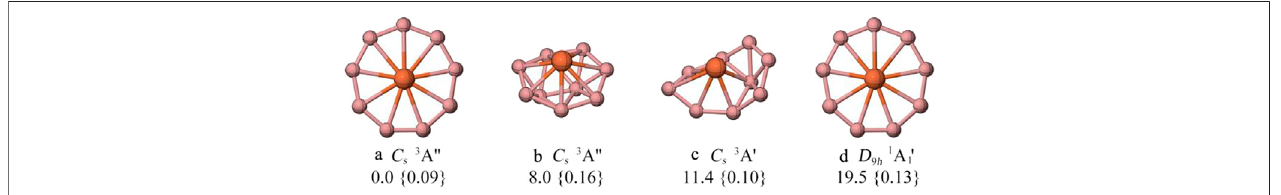
FIGURE1| Thelow-lyingenergyisomersofFeB 9 − computed atthePBE0/def2-TZVPPlevelandT1diagnosticvaluesobtainedwithcoupled-clusterwavefunction are given in curly braces. All energies are corrected from zero-point energies (ZPE) at the PBE0/def2-TZVPP level.